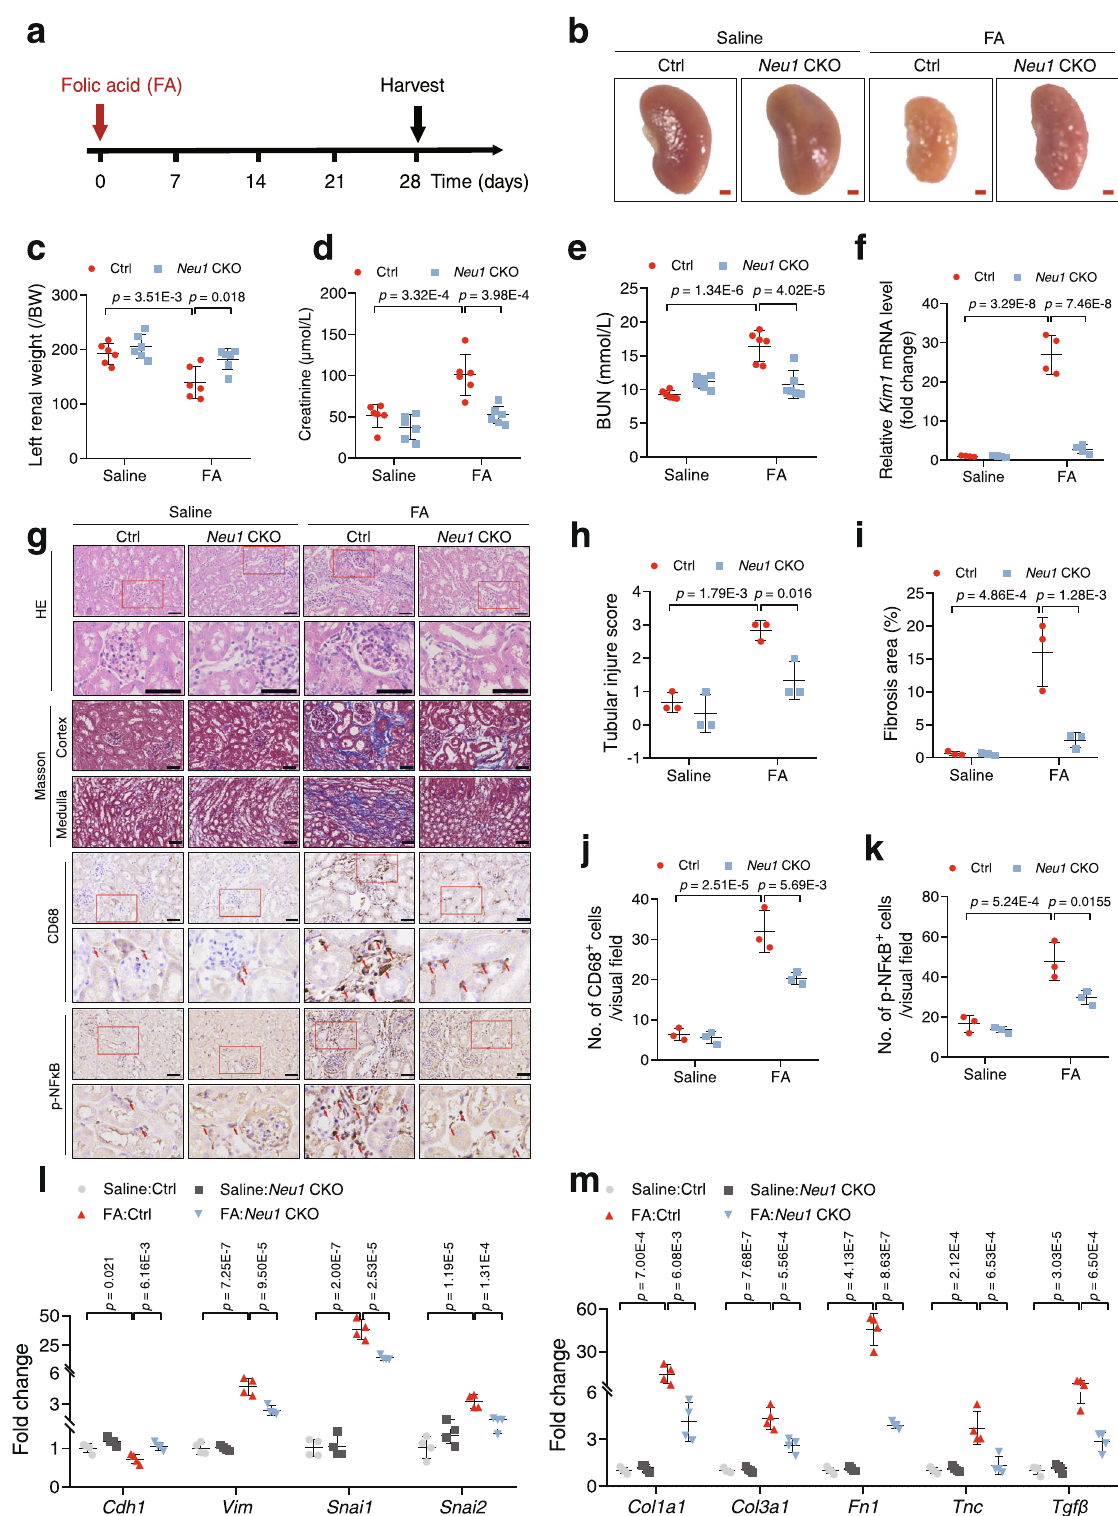
Fig. 4 | TEC-speci fi c deletion of Neu1 alleviates folic acid-induced renal fi brosis in mice. a Scheme of the experimental approach. The mice were intraperitoneally injectedwithfolicacid(250mg/kg). b Thegrossappearanceofwholekidneysfrom control(Ctrl)and Neu1 CKOmice4weeksafterfolicacidinjection.Scalebar,1mm. c The ratio of left renal weight to body weight (BW). n =6 mice per group. d , e Creatinine ( d ) and blood urea nitrogen ( e ) in serum measured by ELISA. n =6 micepergroup. f Kim1 mRNAlevels. n =4micepergroup. g Hematoxylinandeosin (HE), Masson ’ s trichrome staining, and immunohistochemistry staining of CD68